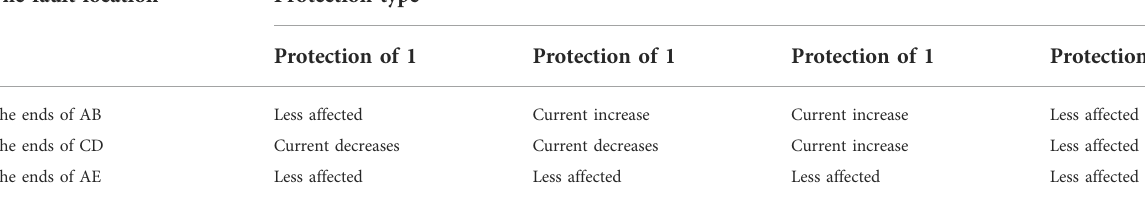
TABLE 3 In fl uence of single DG access on three-phase short-circuit fault current. The fault